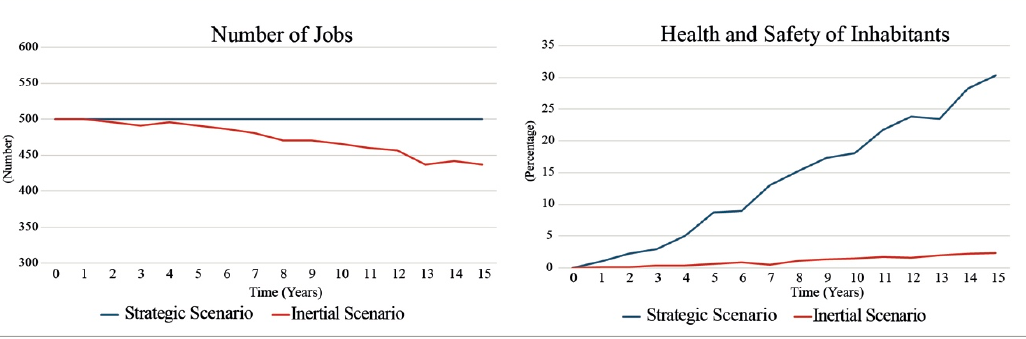
Figure 13. Simulation of the evolution of economic variables over time (Datola et al., 2019) .